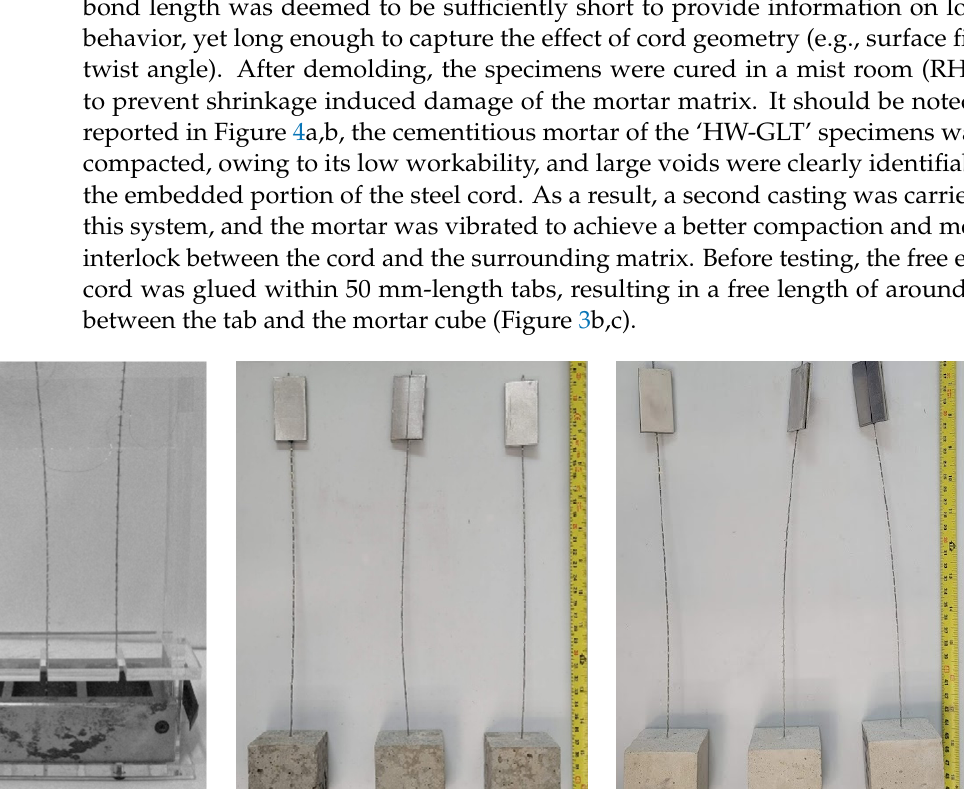
Table 1. Mechanical properties of the mortar matrices.